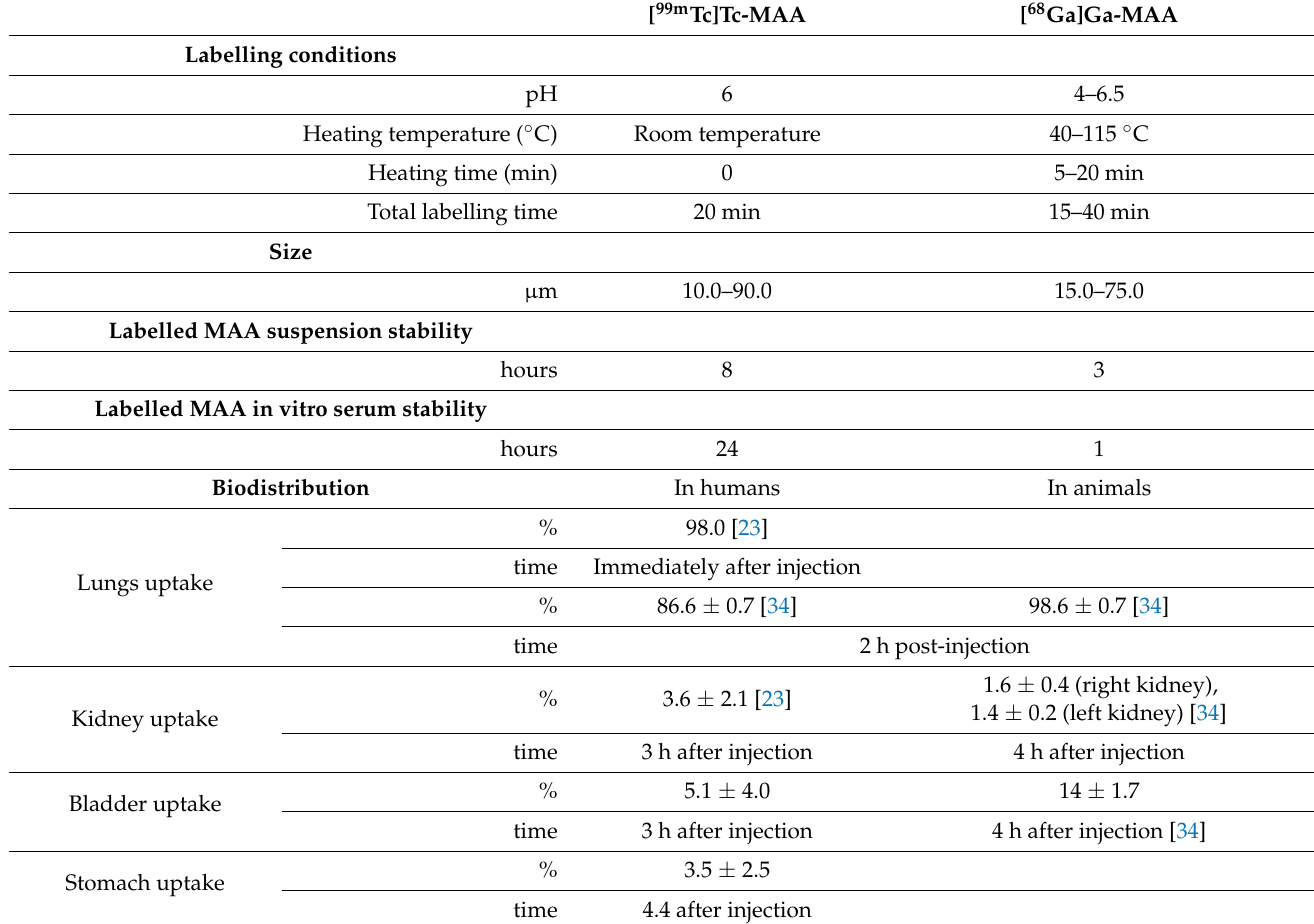
Table 3. Summary of important factors of the switch from 99m Tc to 68